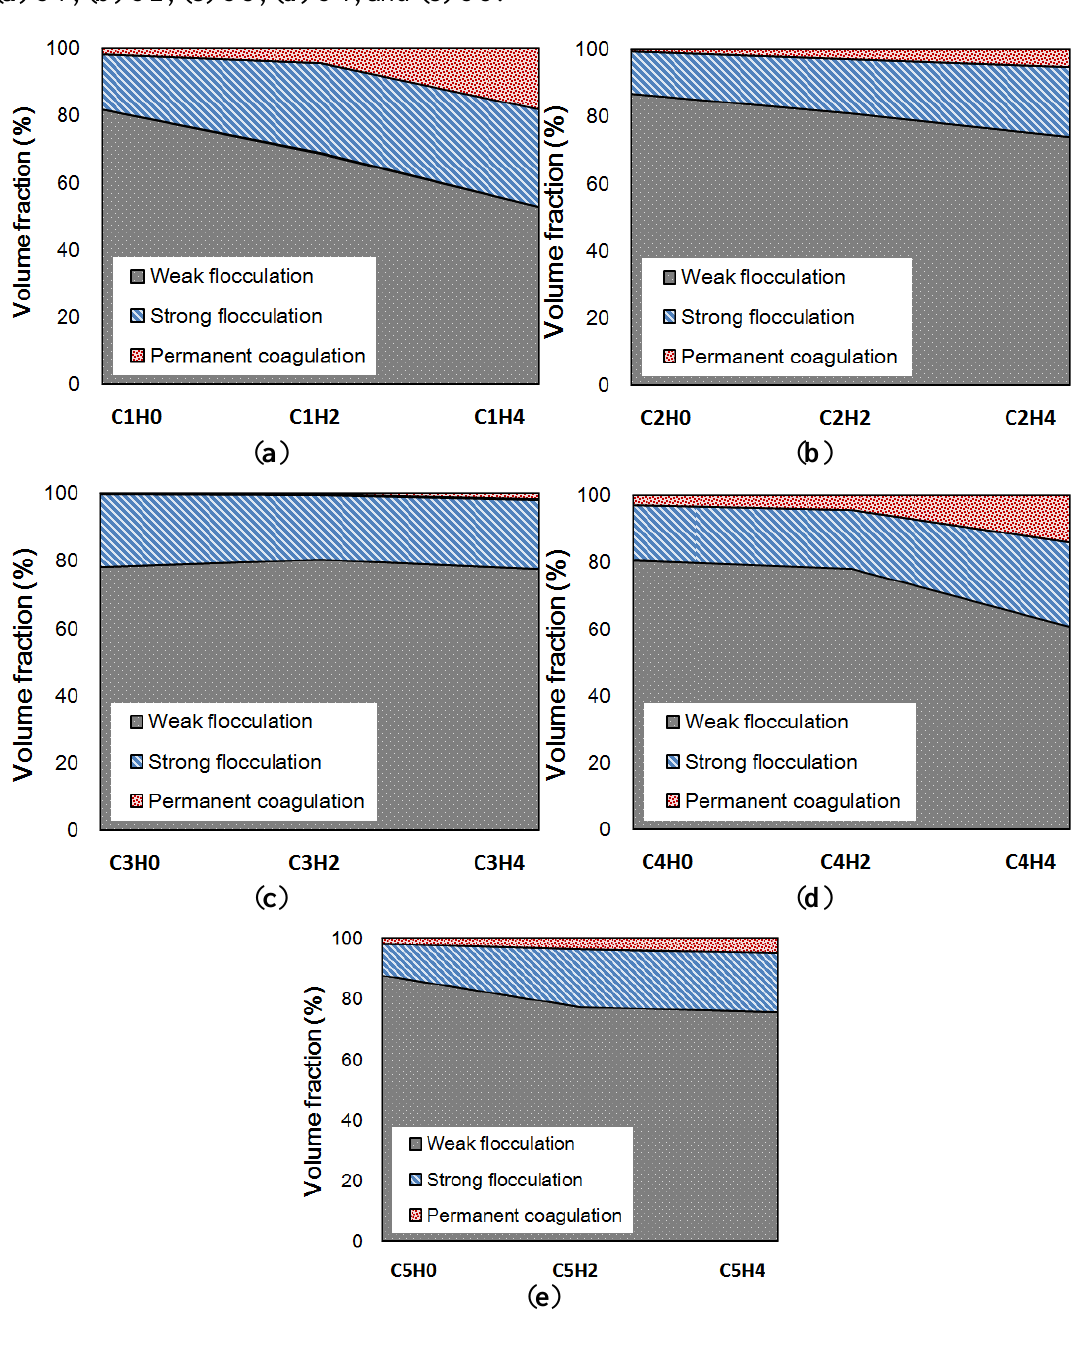
Figure 9. Ratio of suspended particles and its evolution according to cement